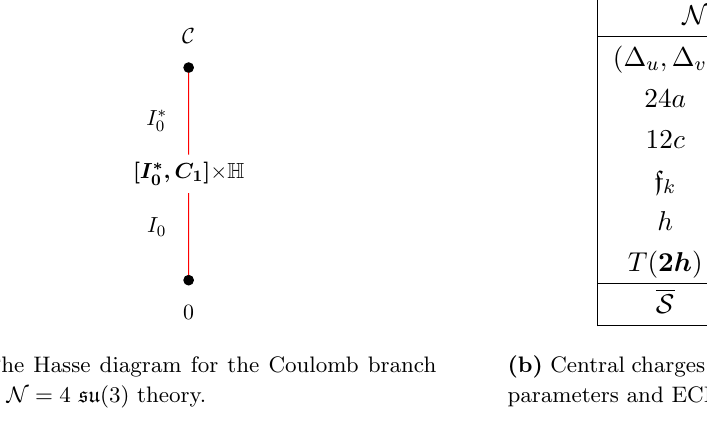
Figure 5. Information about the su (3) N = 4